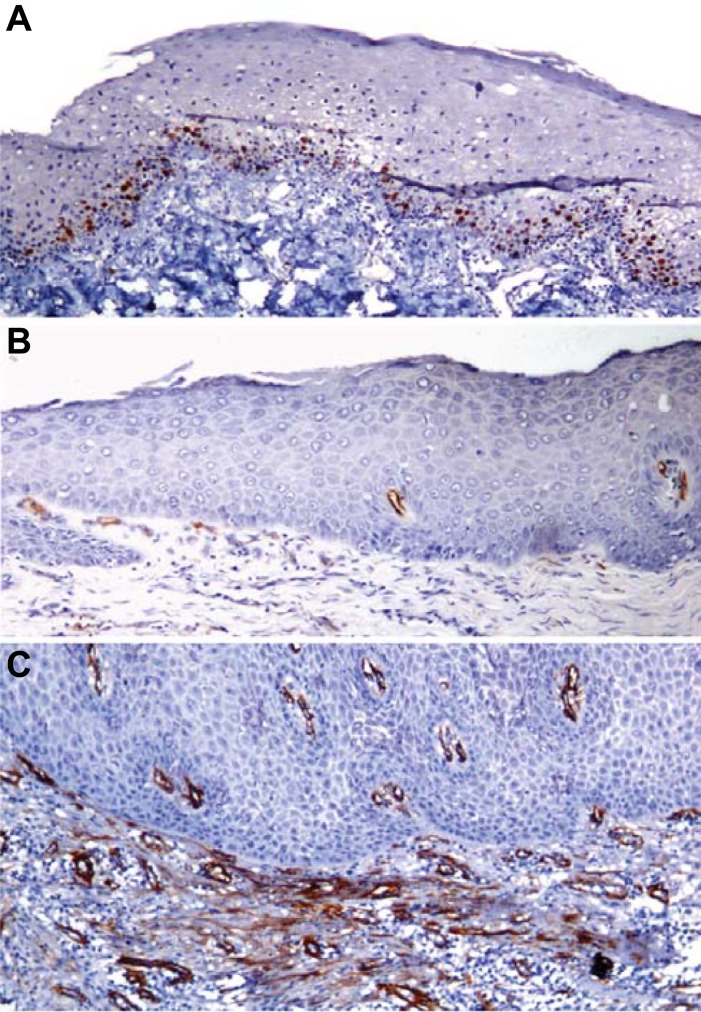
Photomicrograph of LRED Showing a) Ki67 labeling index, b) CD105 (Neoangiogenesis) and c) α-SMA Expression (100X).